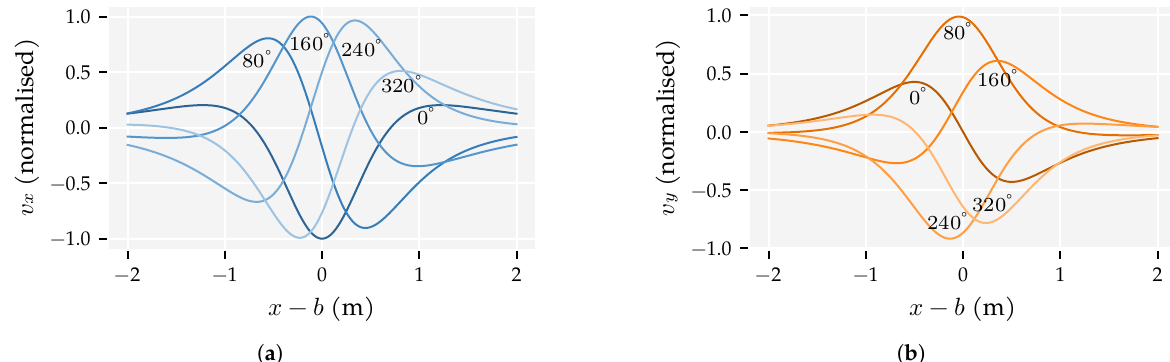
Figure 1. Normalised continuous velocity profiles for five movement directions (indicated) of a source at d = 1 m from the sensor array’s centre: ( a ) v x and ( b ) v y . The sensors are located along the x axis and b is the source sphere is x position in